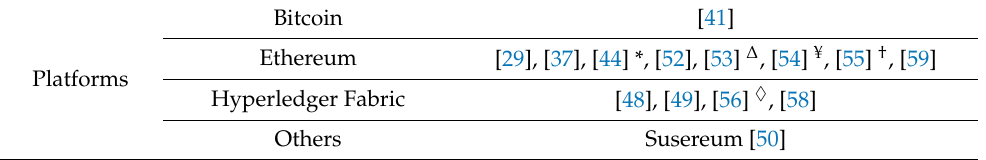
Table 5. Blockchain platforms used in developing SE